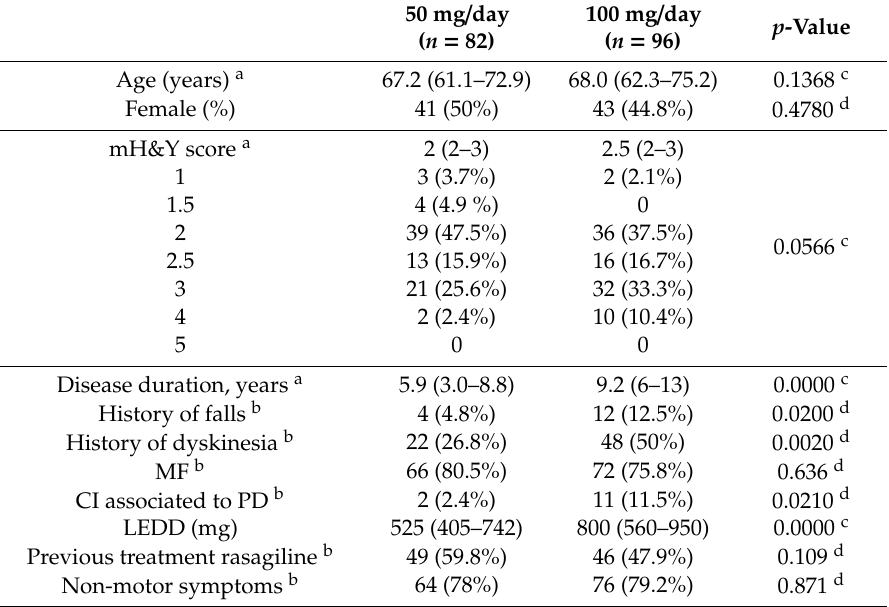
Table 3. Comparison of baseline characteristics between patients with final doses of 50 mg / day vs. 100 mg /